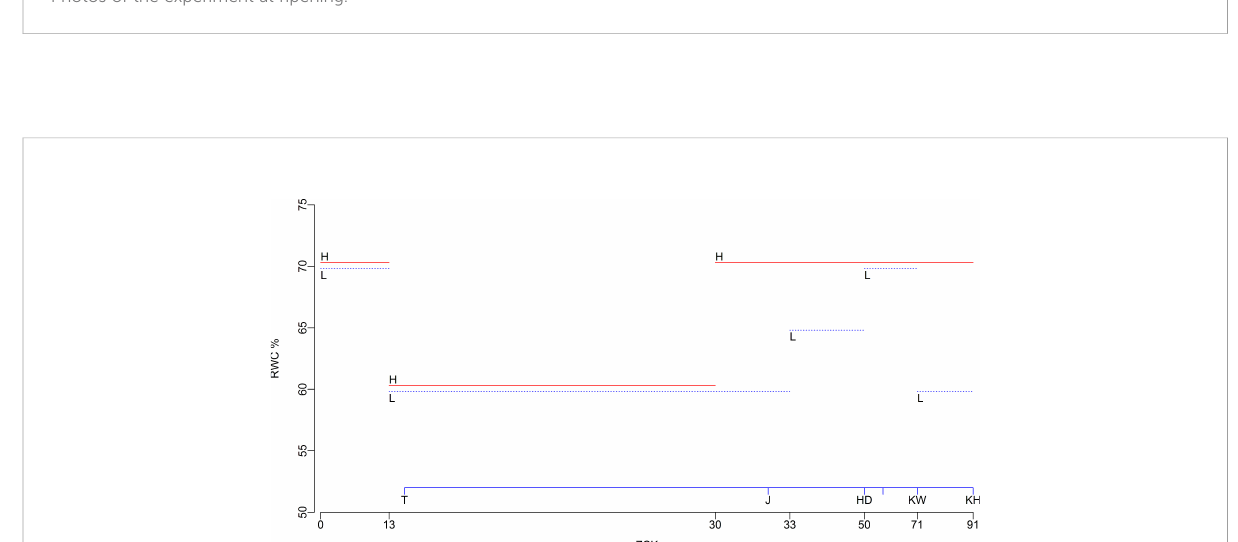
FIGURE 2 The lower limit of soil water content for water treatments. Red and blue lines indicate high-and low-water treatments, respectively. RWC, relative soil water content, percentage of fi eld water capacity; H, high-water treatments; L, low-water treatments; ZCK, Zadoks-Chang-Konzak wheat developmental scale; T, tillering; J, jointing; HD, heading; KW, watery-ripe kernel; KH, hard